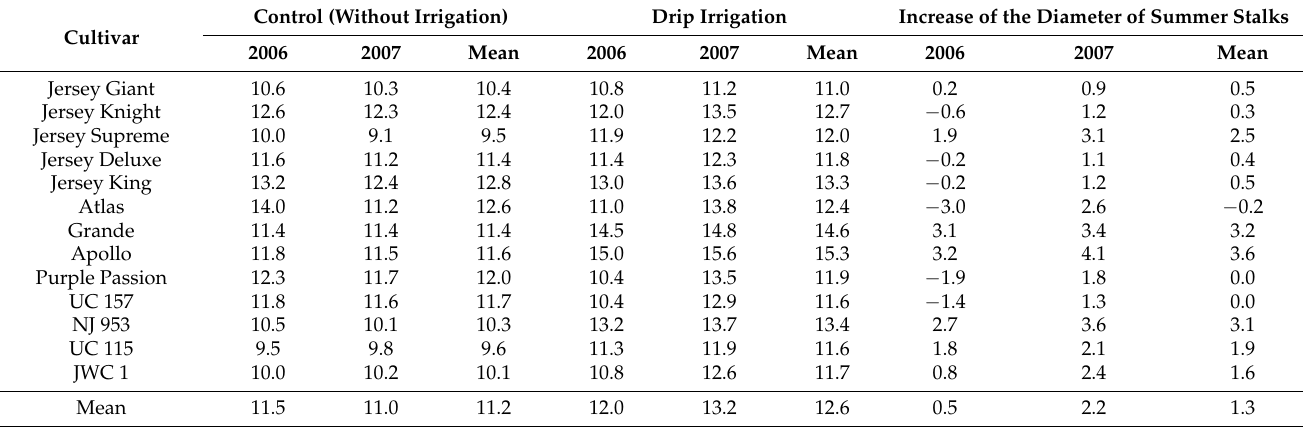
Table 9. Diameter of the asparagus summer stalks (mm) as dependent on cultivar and irrigation. Control (Without Irrigation) Drip Irrigation Increase of the Diameter of Summer Stalks Cultivar Jersey Giant